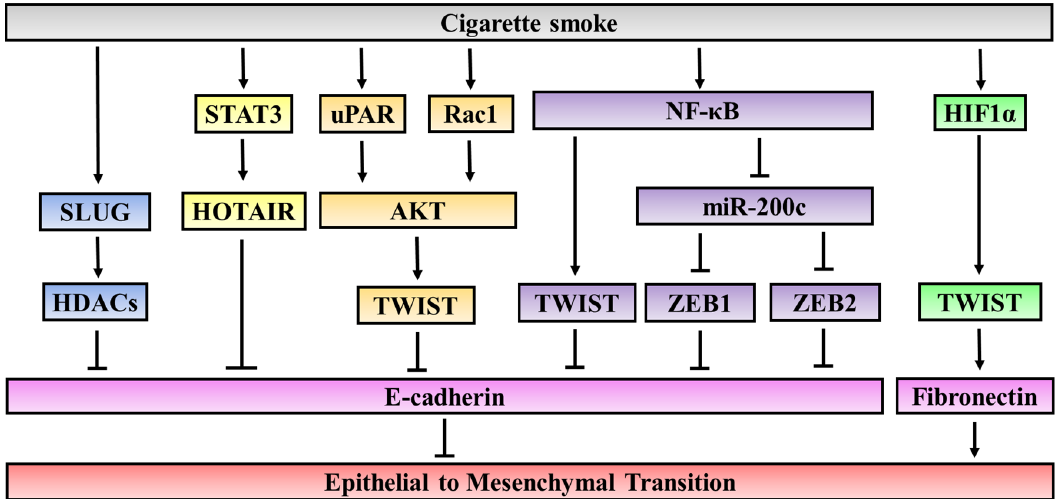
Figure 2. Signaling pathways involved in the inducing effect of cigarette smoke on